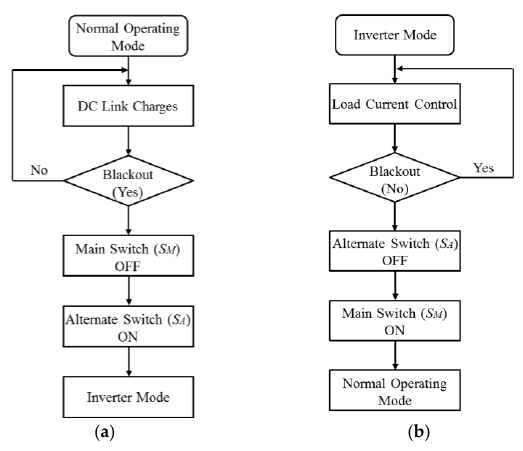
Figure 8. Flowchart for the ( a ) normal operating; and ( b ) inverter modes of the proposed system.